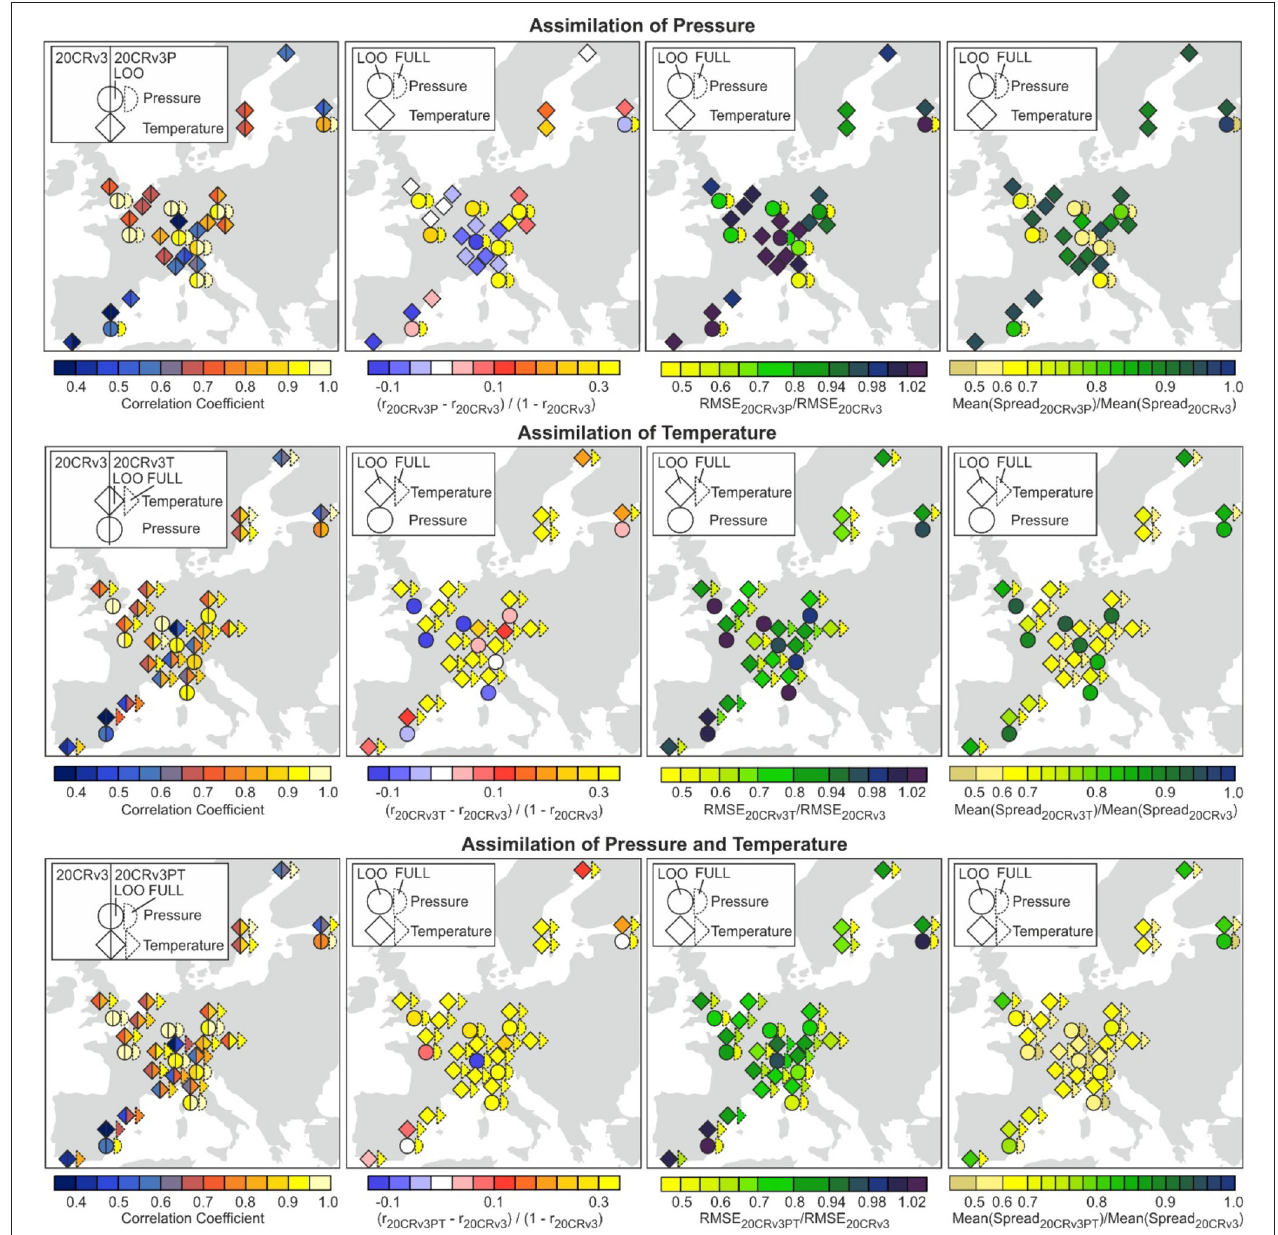
FIGURE 3 | Results of the experiments for 1807 for correlation, scaled improvement (saturated > 0.3 as these cases are visible in the correlation directly), ratio of RMSE, and ratio of ensemble spread. Dashed outlines indicate results from the FULL assimilation that are not independent, solid outlines are based on independent data (data retained for evaluation or LOO approach). Note that some of the color-scales are not equidistant.